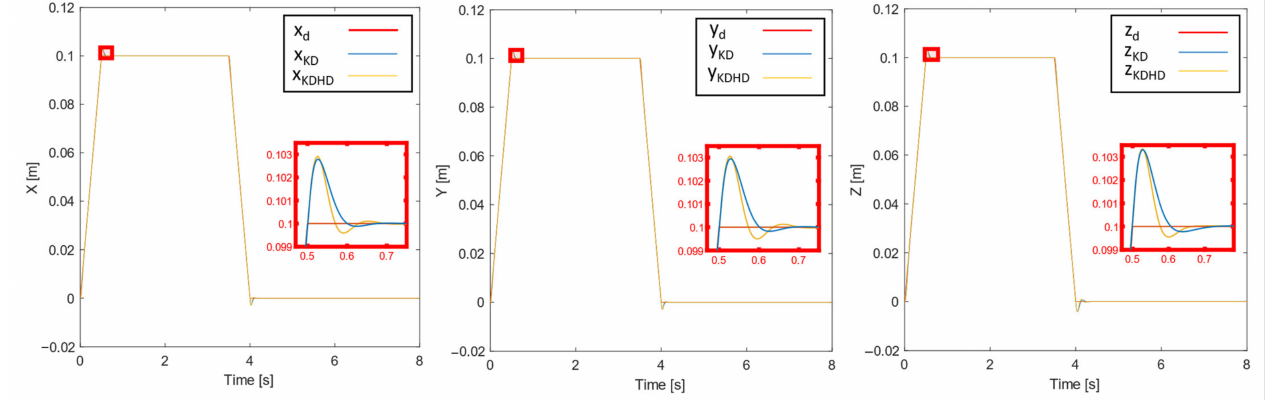
Figure 6. Case study A, k KD = k KDHD = 1 · 10 4 N/m, KD-KDHD comparison number I, ramp time t ramp = 0.5 s, stop time t stop = 3 s, external coordinates.